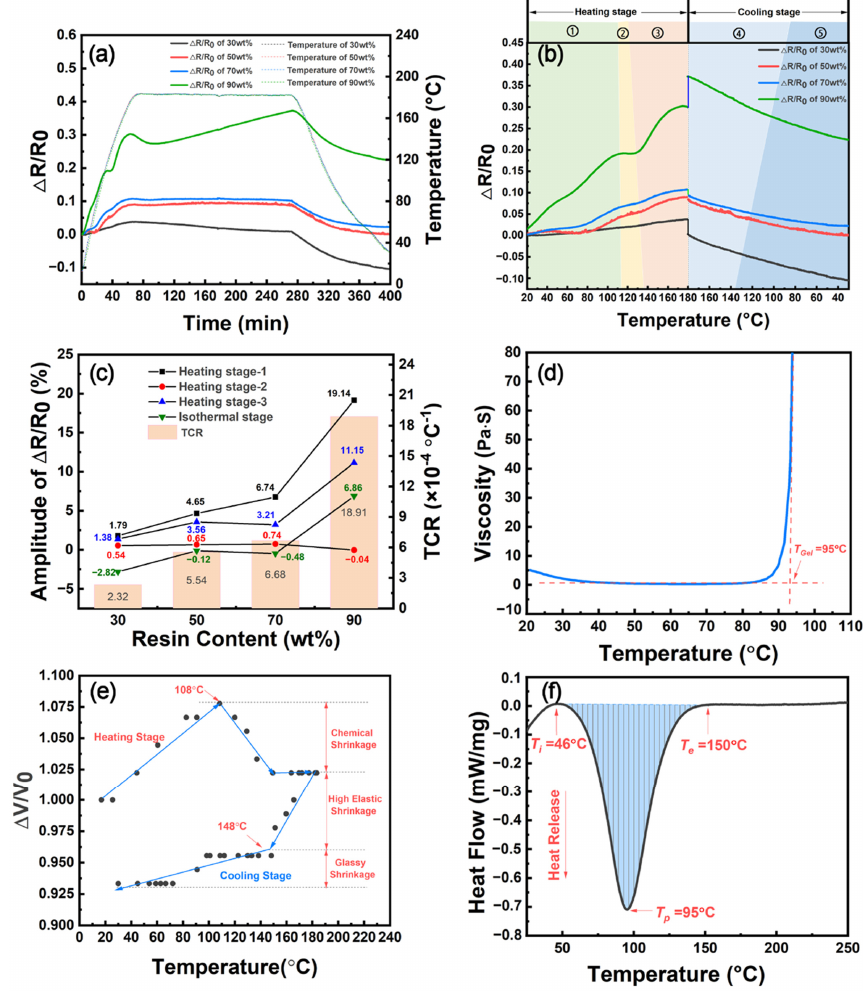
Figure 9. The electrical resistance variation with ( a ) time and ( b ) temperature for CNT/E51-EDA samples with different resin contents during curing process; ( c ) the amplitude of the electrical resistance variation and the TCR for CNT/E51-EDA samples with different resin contents; and ( d ) the resin viscosity, ( e ) the relative volume change, and ( f ) the heat flow with temperature for